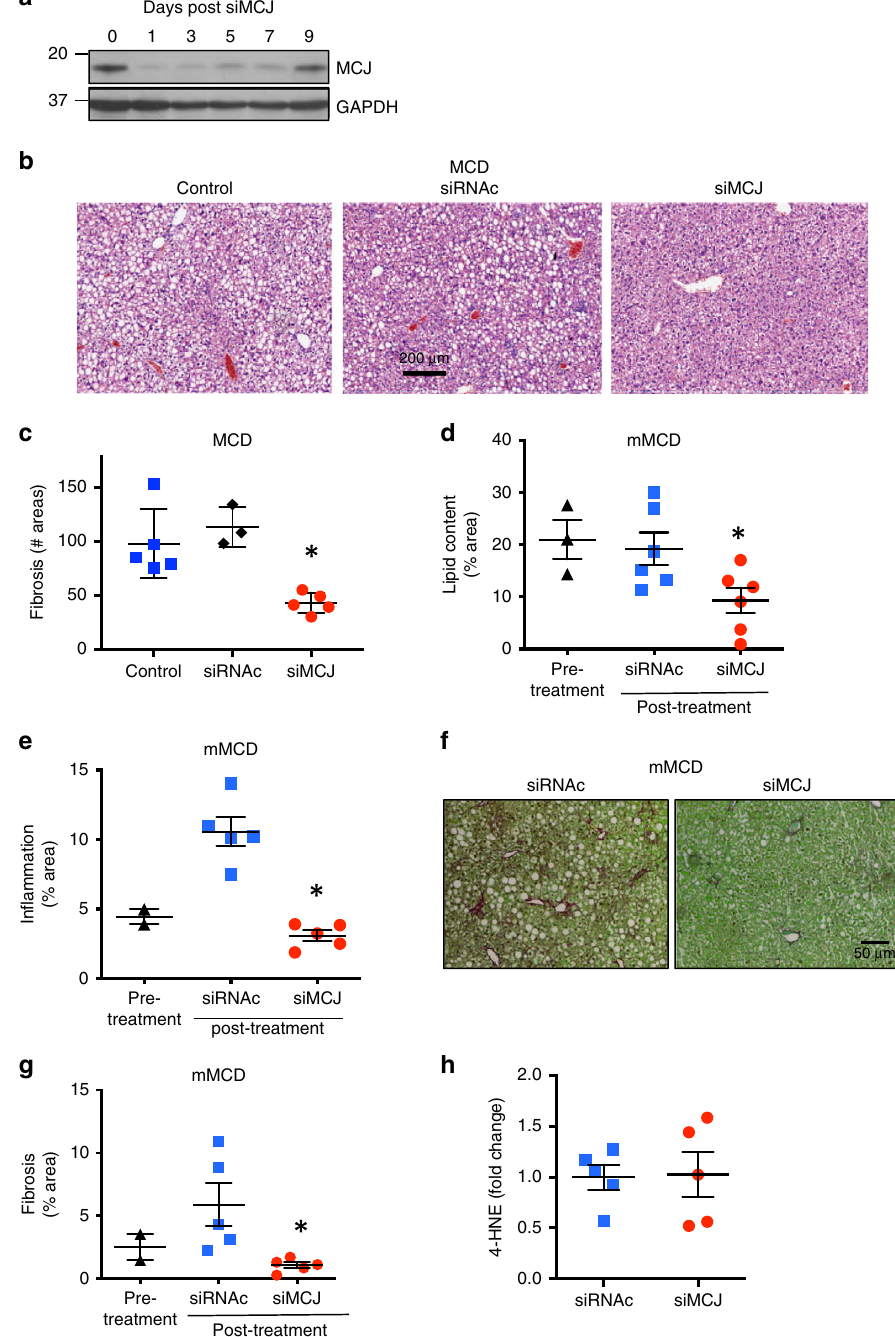
Fig. 3 Reducing MCJ levels in the liver by in vivo administration of siMCJ decreases liver steatosis and fi brosis in the MCD diet models. a WT mice received a single i.v. dose (1.7 mg/Kg) of siMCJ using Invivofectamine as a delivery system. Livers were harvested at the times indicated and MCJ levels were examined by Western blot analysis. b and c WT mice were placed on MCD diet and received an i.v. administration of Invivofectamine-formulated siMCJ ( n = 5), Invivofectamine-formulated nonspeci fi c control siRNA (siRNAc) ( n = 3), or PBS ( n = 5) weekly starting at the initiation of the diet. Mice were harvested after 3 weeks on MCD diet (1 week after the last dose of siMCJ). b Representative images of liver lipids by H&E staining of liver sections are shown. c Number of fi brotic areas per histological section of the liver as determined by Picro Sirius Red staining. d – g WT mice were placed on mMCD for the duration of the study. After 1 week on mMCD diet (pre-treatment), mice were administered weekly i.v. dose of Invivofectamine-formulated siMCJ ( n = 6) or siRNAc ( n = 6) for a total of 3 weeks and harvested 1 week after the last dose (4 weeks total on the diet). d Quanti fi cation of liver lipid content by Sudan III staining of histological sections. e Quanti fi cation of liver in fl ammation by F4/80 immunostaining of histological sections. f Representative images and ( g ) quantitation of liver fi brosis by Picro Sirius Red staining. h Quanti fi cation of 4-HNE staining of liver sections. * p < 0.05 siMCJ-treated compared with PBS control by one-way ANOVA or Student ’ s t test analysis. Error bars show standard error (SE) in ( d ), ( e ), ( g ) and ( h ), and standard deviation (SD) in ( c ). Source data are provided as a Source Data fi